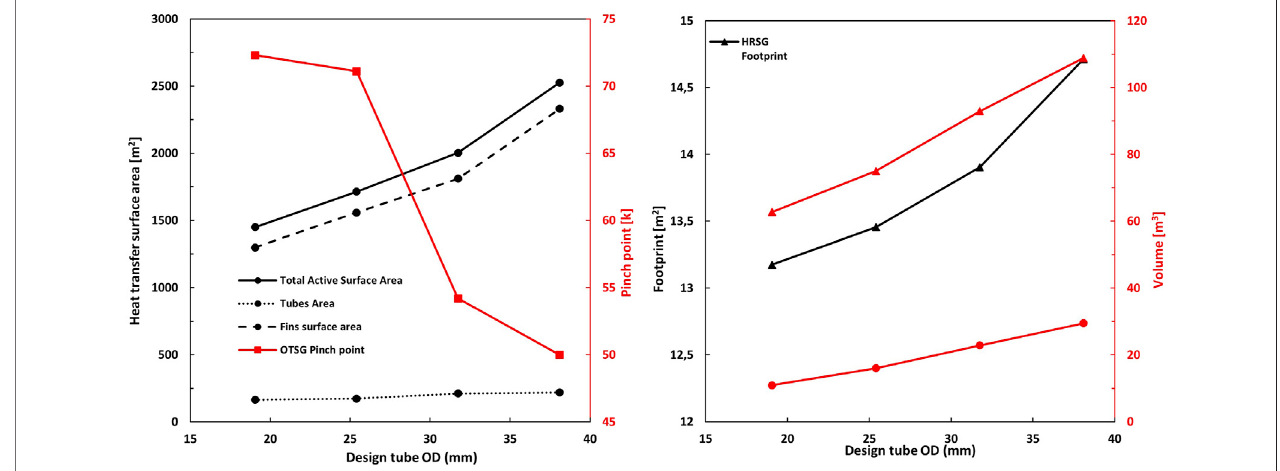
FIGURE 7 | Results of design optimization for minimum weight. More detailed results are found in Supplementary Table S8 . All the designs have a cycle net power output of 13.2 MW. (A) Heat transfer surface area distribution (total, tubes and fi ns) and pinch point; and (B) surface footprint and volume footprint.